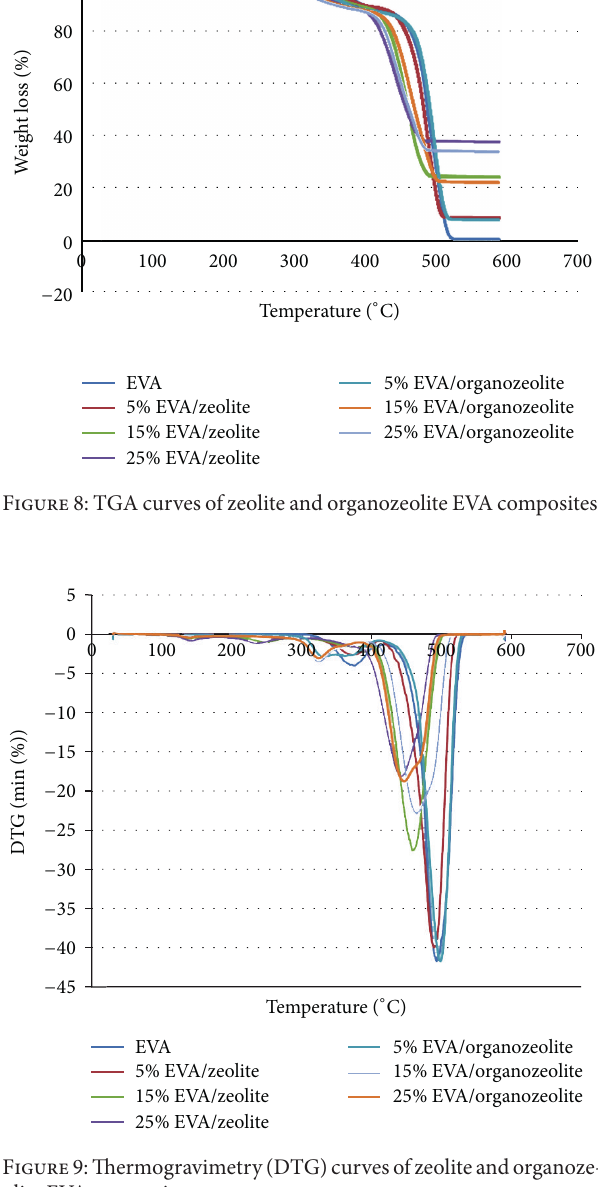
Figure9:Thermogravimetry(DTG)curvesofzeoliteandorganoze- olite EVA composites.